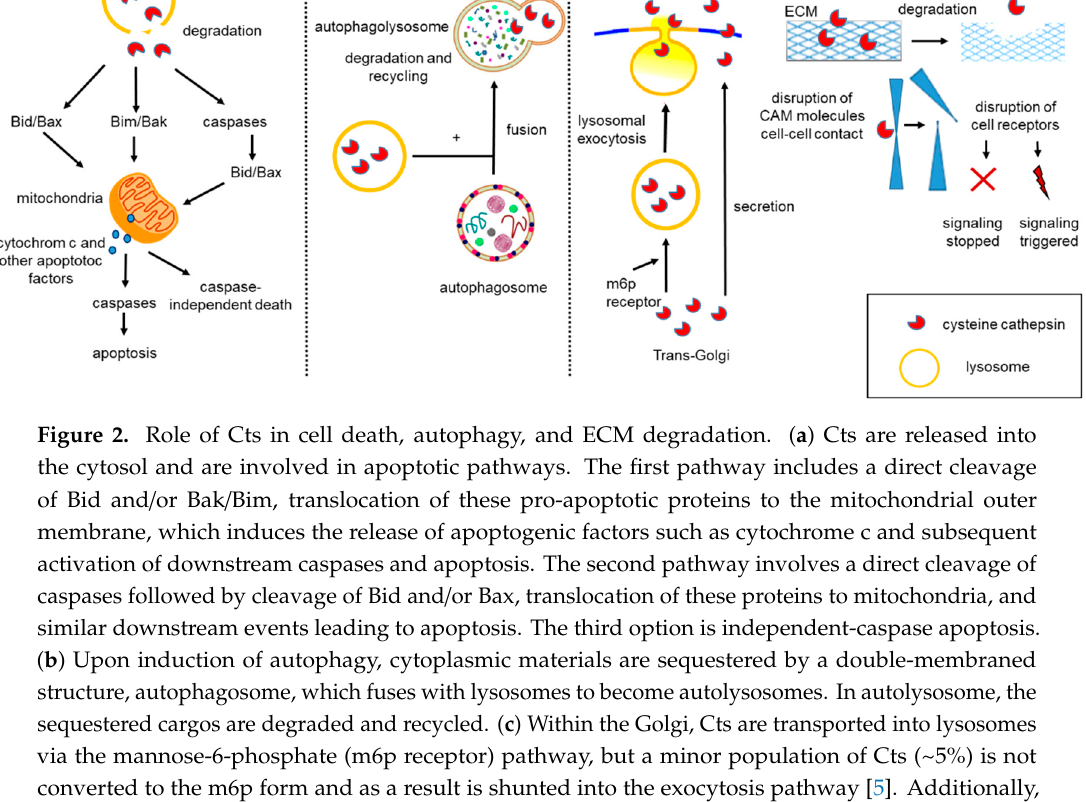
converted to the m6p form and as a result is shunted into the exocytosis pathway [5]. Additionally,